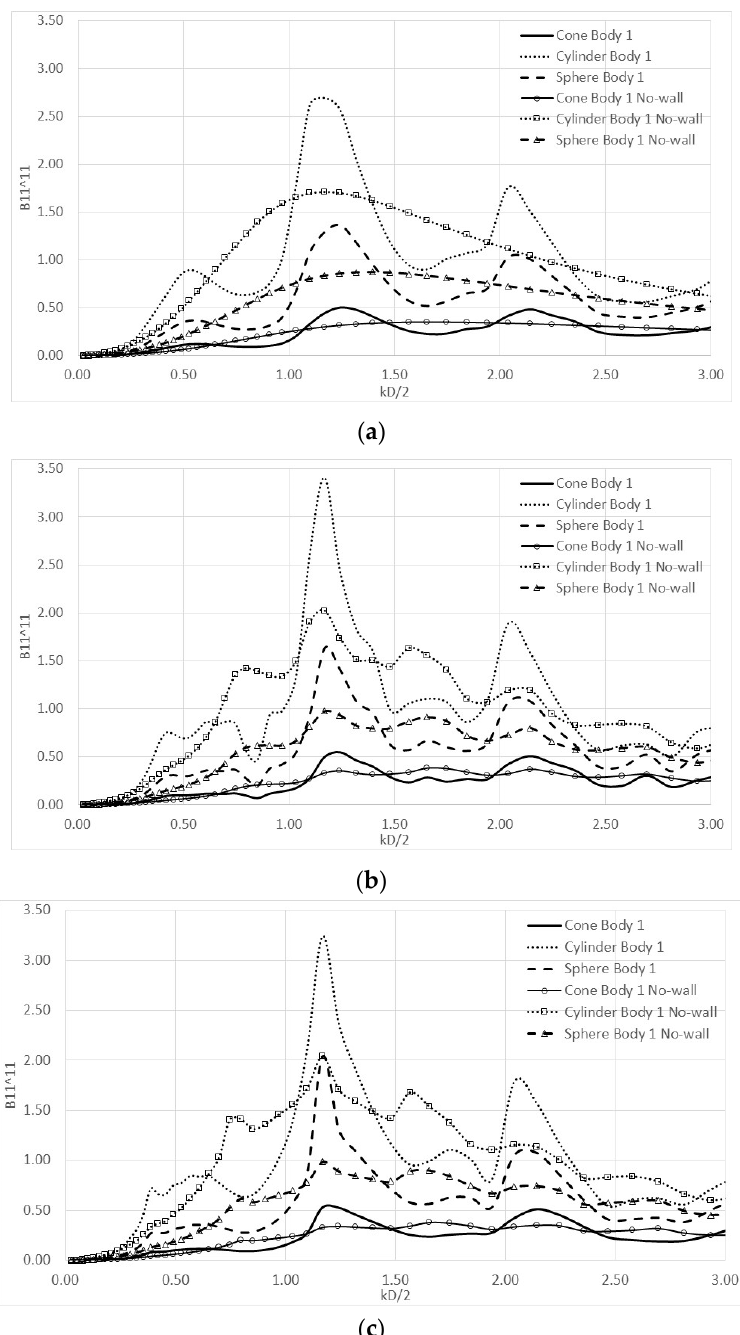
Figure 12. Dimensionless damping coefficient of the 1st floater at the surge direction due to its motion at surge against kD/2, for the three different examined array configurations. Comparison with the corresponding damping coefficient of the same floater of the arrays without the presence of the breakwater: ( a ) parallel arrangement, C 1 ; ( b ) rectangular arrangement, C 2 ; ( c ) perpendicular arrangement, C 3 .